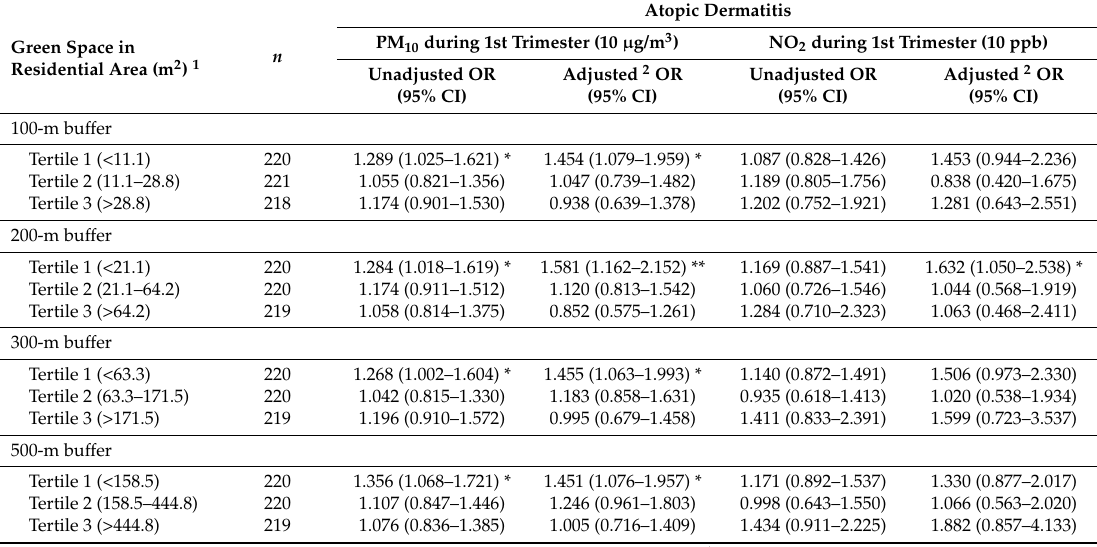
Table 4. Risk of atopic dermatitis in 6-month-old children with exposure to ambient PM 10 /NO 2 during the first trimester of pregnancy stratified by the level of green space in the residential